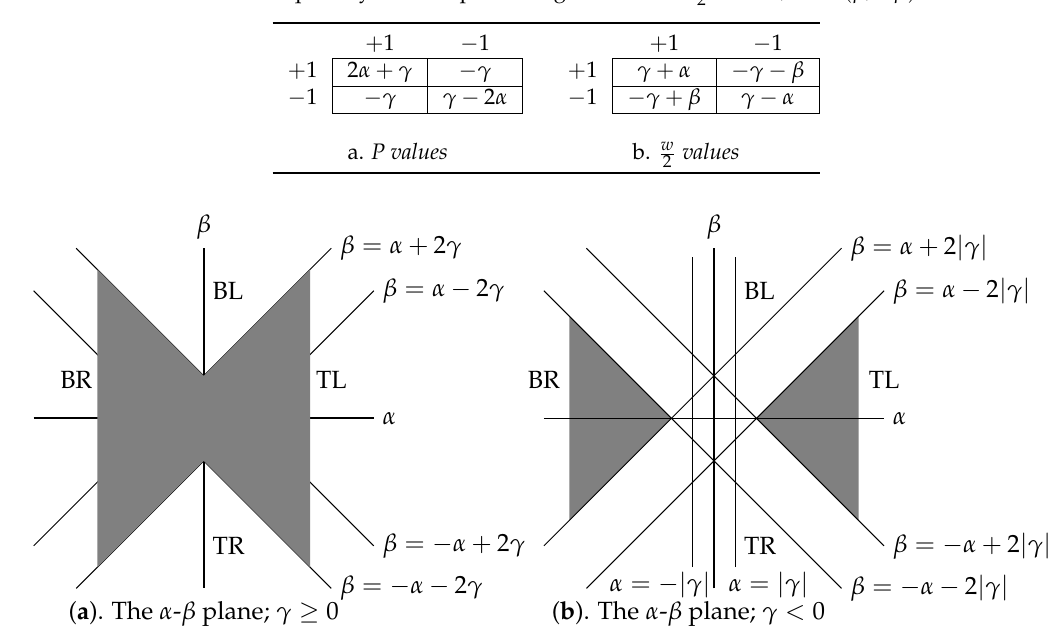
values, with ( β , − β ) . 2